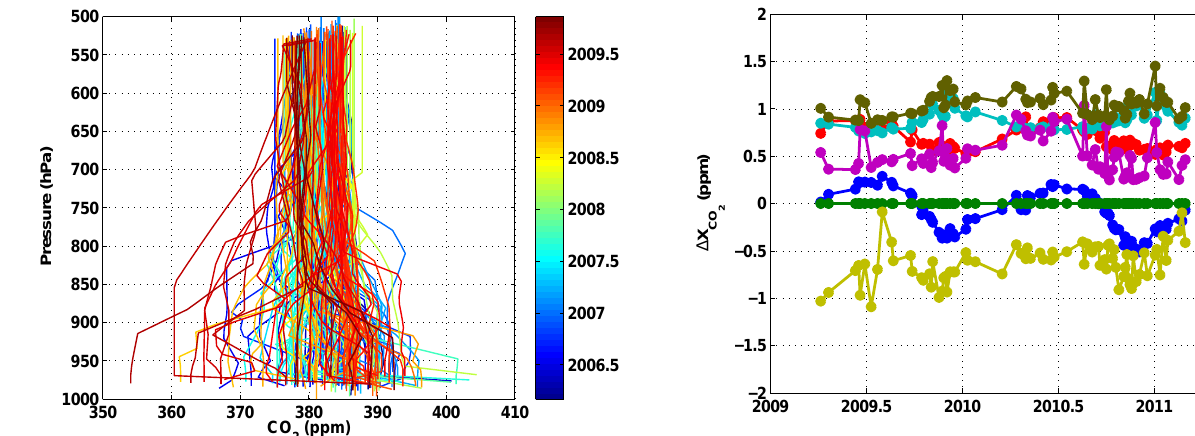
Fig. 10. All the Cessna profiles over Lamont, OK, are shown on a pressure grid, coloured by the time the profile was measured. These profiles are detrended to show only the seasonality and variability.